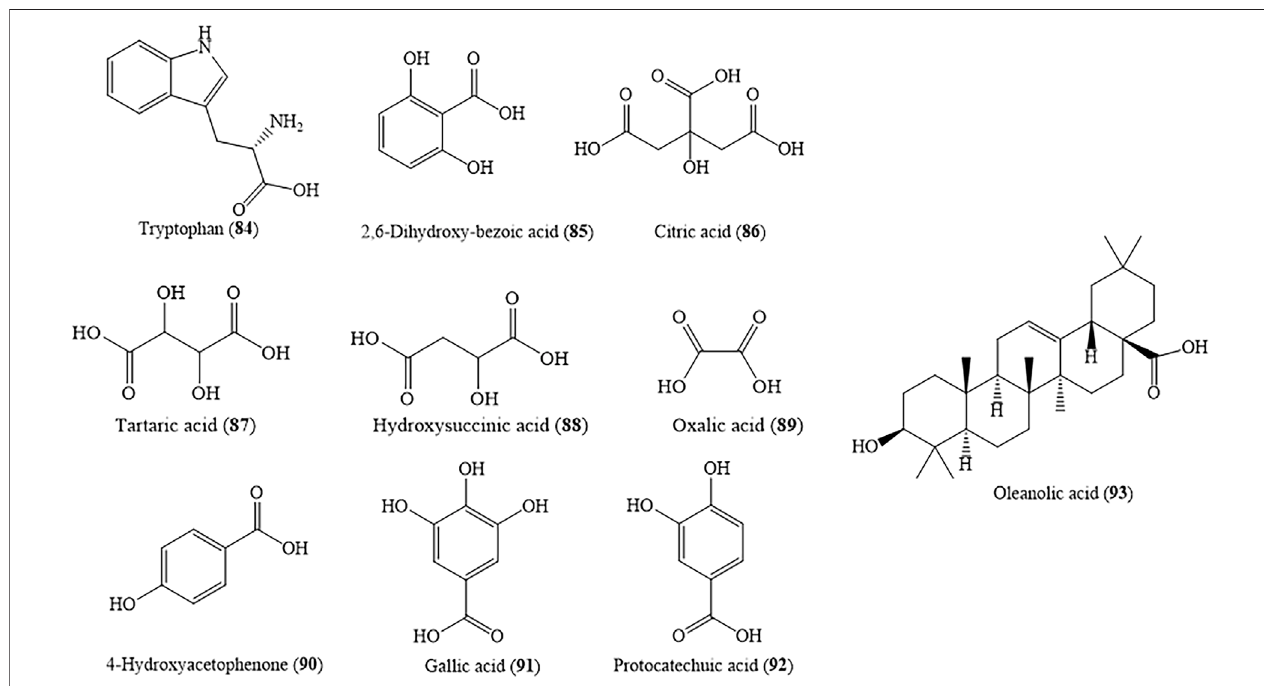
FIGURE 7 | Major organic acids presenting in